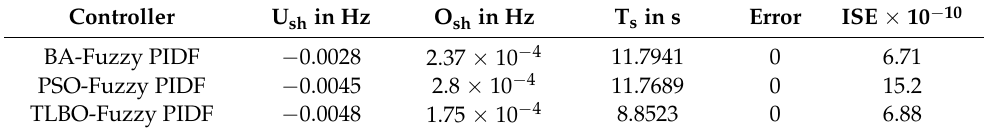
Table 12. Frequency response performance with Fuzzy PIDF controllers designed via ISE.